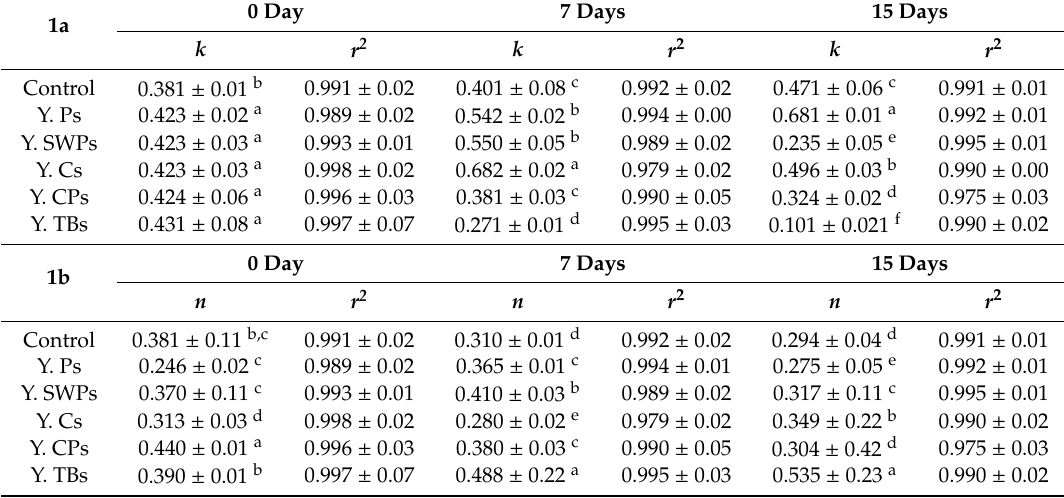
Table 1. The consistency index ( k ) and flow behavior index ( n ) of yogurt prepared with di ff erent